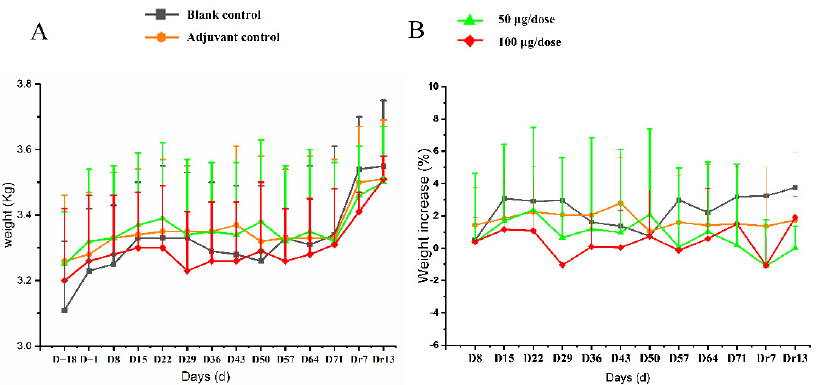
Figure 3. The changes of body ( A ) weight and ( B ) rate of body weight gain in cynomolgus monkeys for 4 times re-peated injections of ZF2001 vaccine study. n = 10 on study D − 18-D71, n = 4 on study Dr7 and Dr13 in each group vs. the blank group ( p > 0.05).